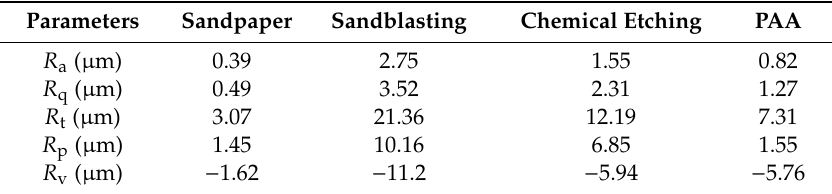
Table 4. Values of roughness parameters with different surface treatments.